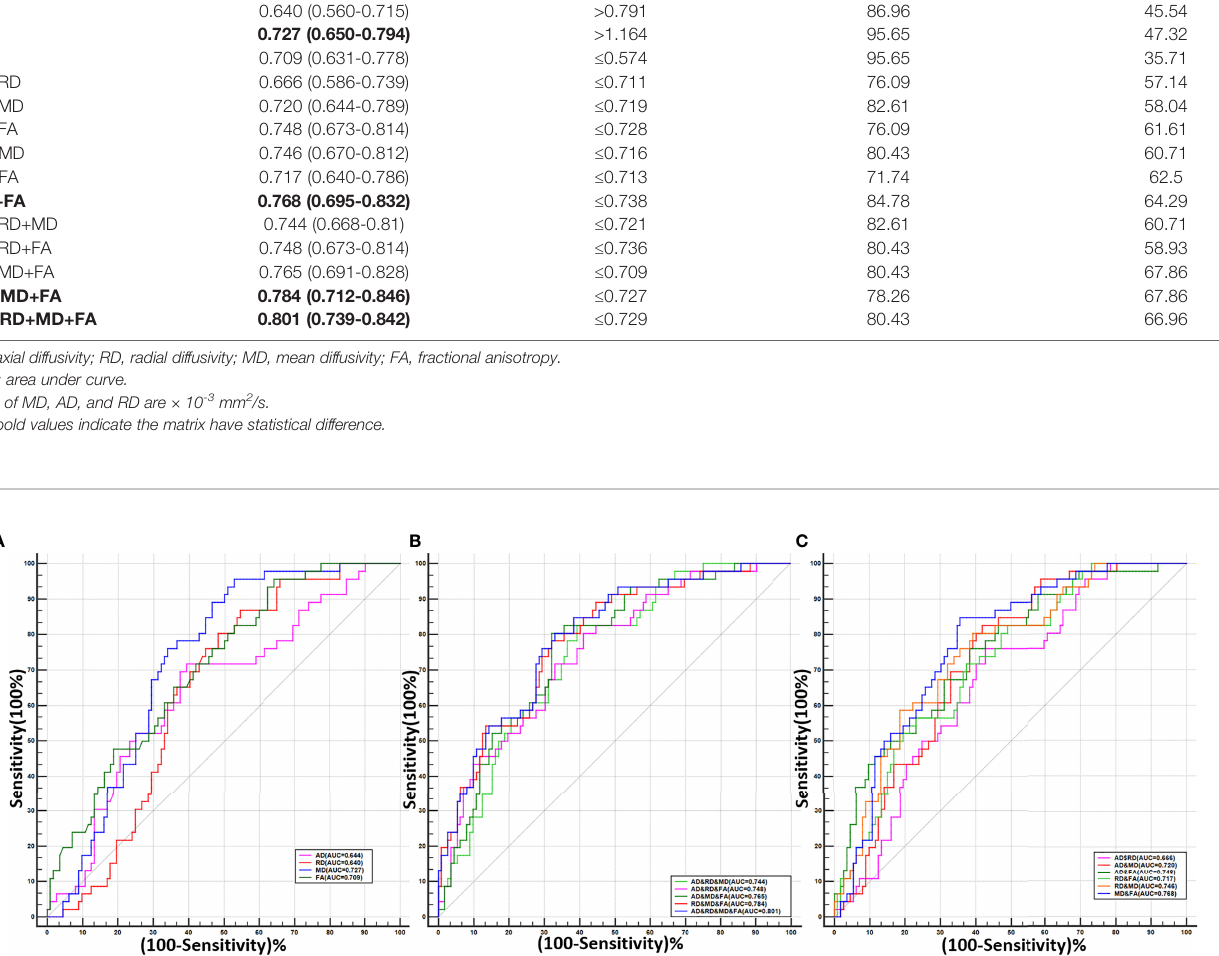
FIGURE 3 | The receiver operating characteristic (ROC) curves for single or combined DTI parameters of the optic nerve to differentiate patients with and without dysthyroid optic neuropathy. (A) The ROC curves of the four single DTI parameters. (B) The ROC curves of the combination of any two DTI parameters. (C) The ROC curves of the combination of any three DTI parameters and all four